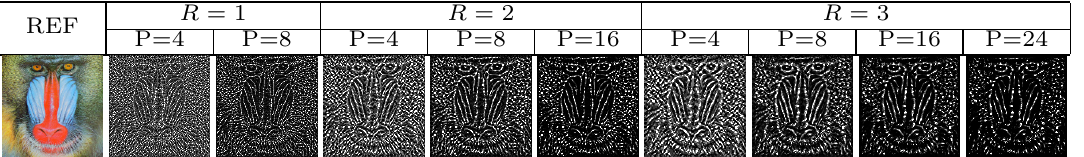
Figure 4. Reference image and its correspondent Local Binary Pattern (LBP) channels computed using three different radius (R)